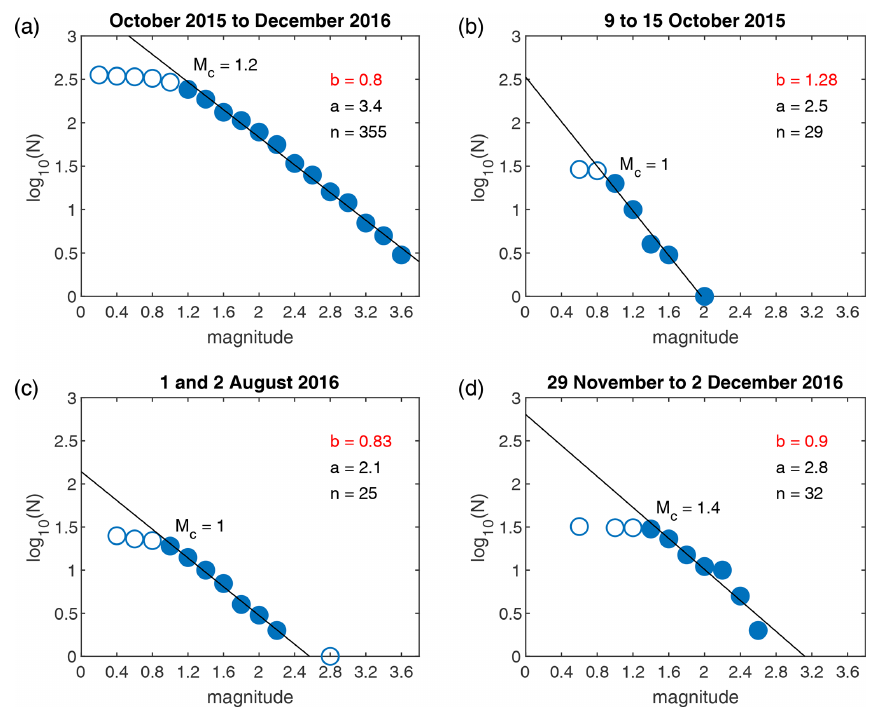
Figure 8. Magnitude–frequency relation for earthquakes observed during (a) the study period, (b) the period of elevated seismic activity from 9 to 15 October 2015, (c) the seismic crisis on 1 and 2 August 2016, and (d) the period of elevated seismic activity from 29 November to 2 December 2016. Magnitudes are binned in steps of 0.2, and n corresponds to the number of events during the period under consideration. Data points used to fit the straight line for the determination of a and b are marked with filled